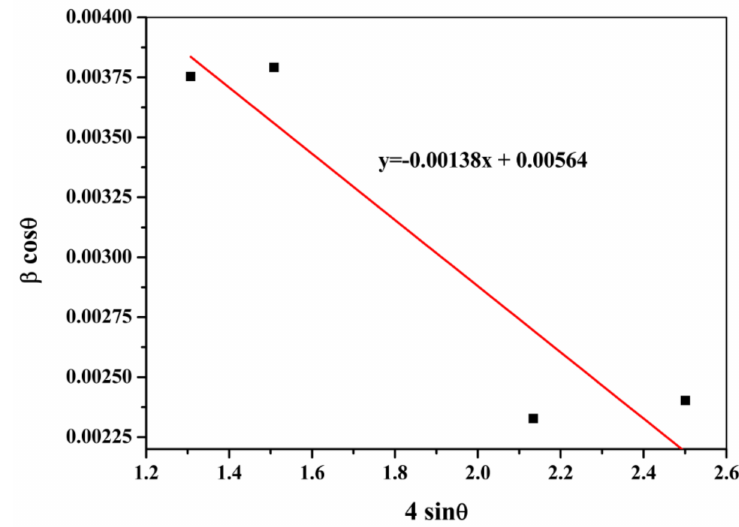
Figure 4. Williamson Hall Plot of β cos θ vs. 4 sin θ of Ag-NPs sample.